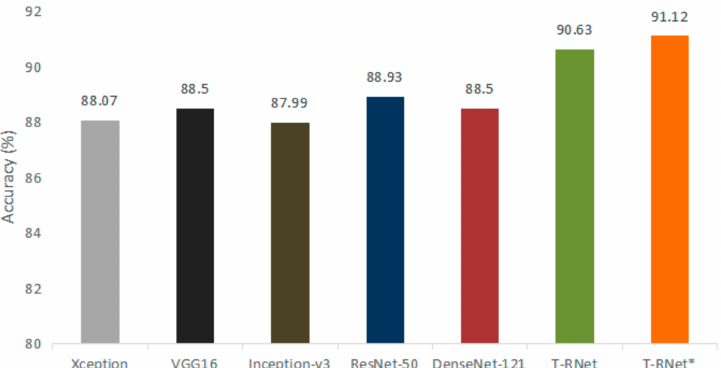
Figure 6. Accuracy comparison of different classification methods on the cassava leaf disease dataset. (T-RNet * indicates the combination of T-RNet and FAMP-Softmax